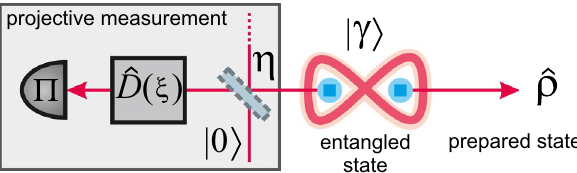
Figure 1. Variation of the conditional preparation scheme. We start with a two mode squeezed vacuum state γ . One of its modes is then displaced with ˆ D (ξ) and measured, using either APD, PNRD or an APD cascade | � approximating PNRD. The detection outcome is characterized by the POVM element ˆ (cid:31) . We model overall losses and inefficiencies within the scheme using a beam splitter with intensity transmittance η to represent attenuation of the signal state in the